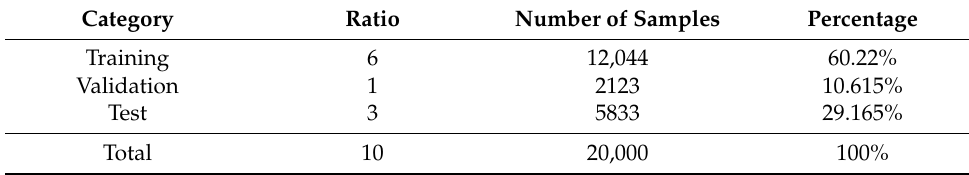
Table 2. Data distribution in the